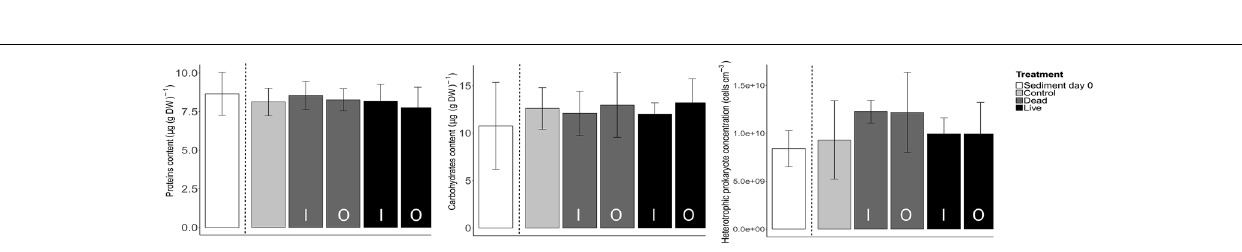
Frontiers in Marine Science |